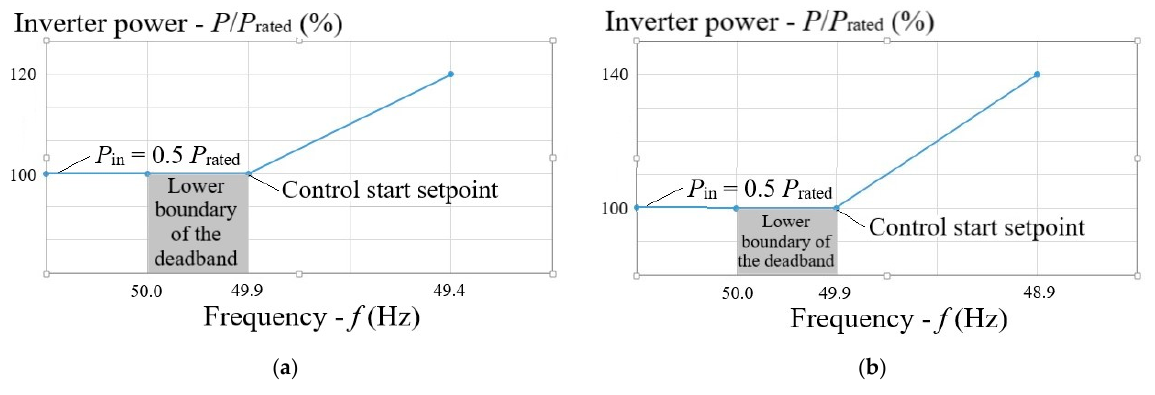
Figure 7. Graphs of the inverter power increase: ( a ) at f 2 = 49.4 Hz; ( b ) at f 3 = 48.9 Hz. 5.